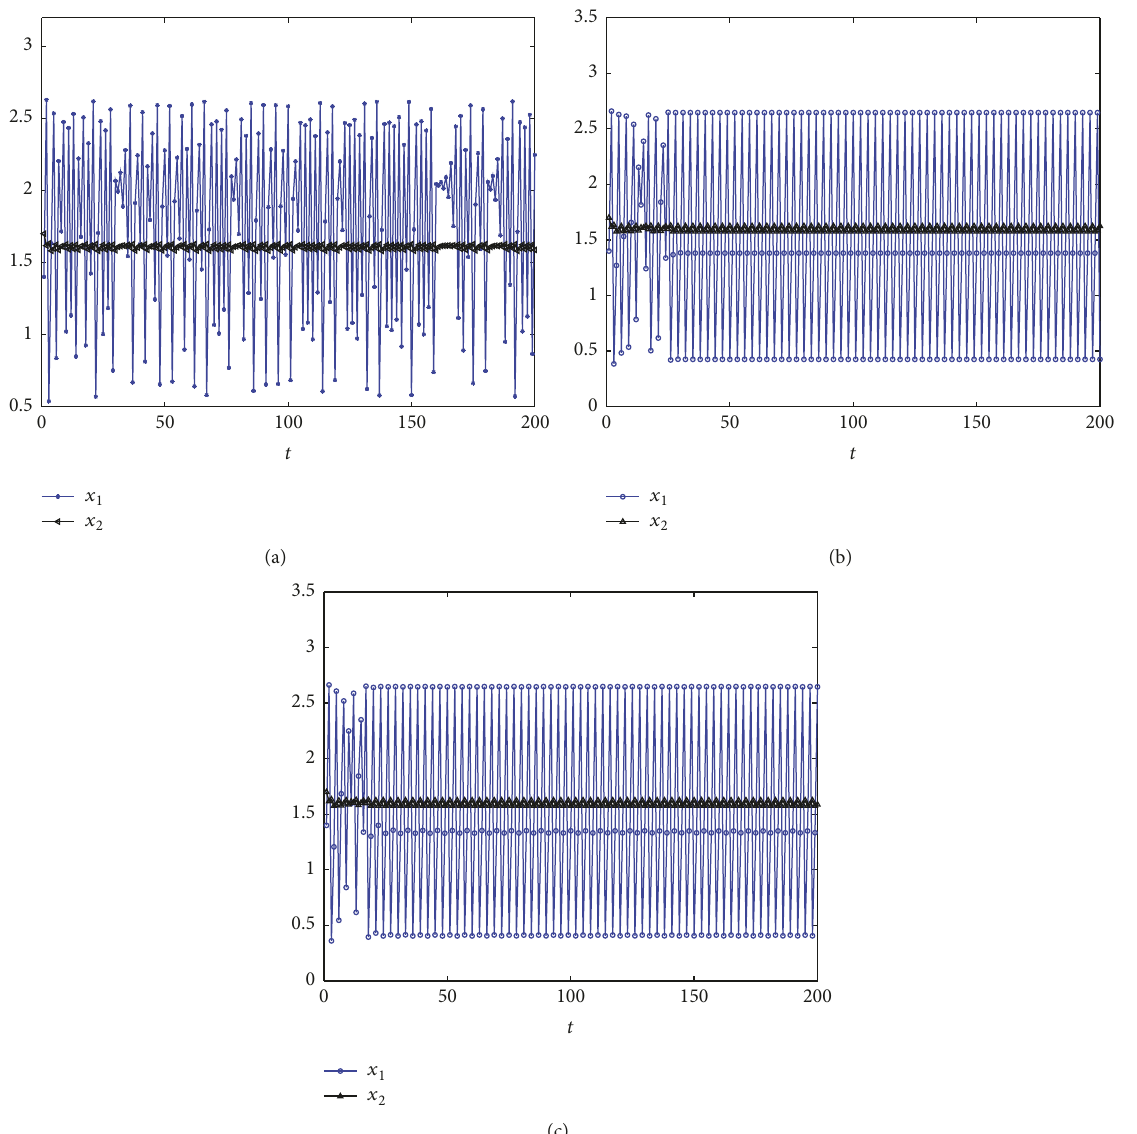
Figure 6: Phase diagram of system (9) for (a) (𝛼 1 = 1.39, 𝛼 2 = 0.36) ; (b) (𝛼 1 = 1.423, 𝛼 2 = 0.36) ; (c) (𝛼 1 = 1.428, 𝛼 2 = 0.36)